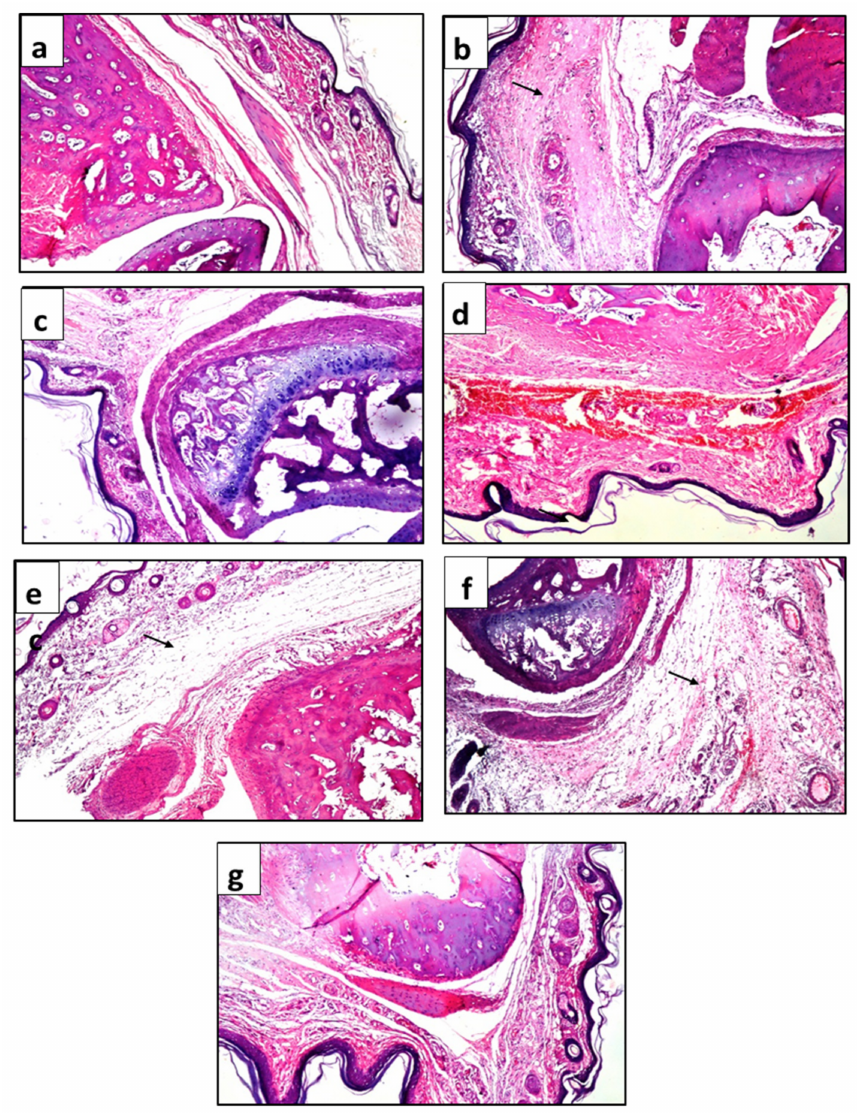
Figure 4. Photomicrographs of subcutaneous and dermal tissues of treated rats. ( a ) healthy animals; ( b ) animals treated with carrageenan only; ( c ) 1% hydrocortisone cream; ( d ) base cream; ( e ) 2.5% JILE cream; ( f ) 5% JILE cream; ( g ) 10% JILE cream. Arrows refer to inflammatory cell infiltration.